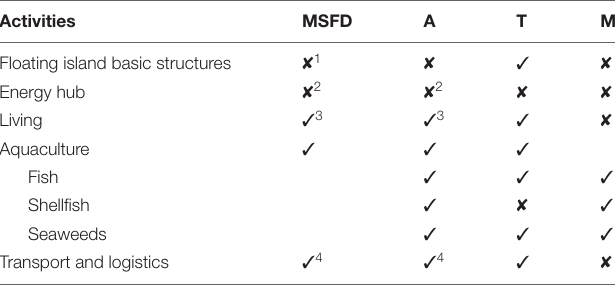
TABLE 1 | List of activities identified for Space@Sea, representing the applications as described by Flikkema and Waals